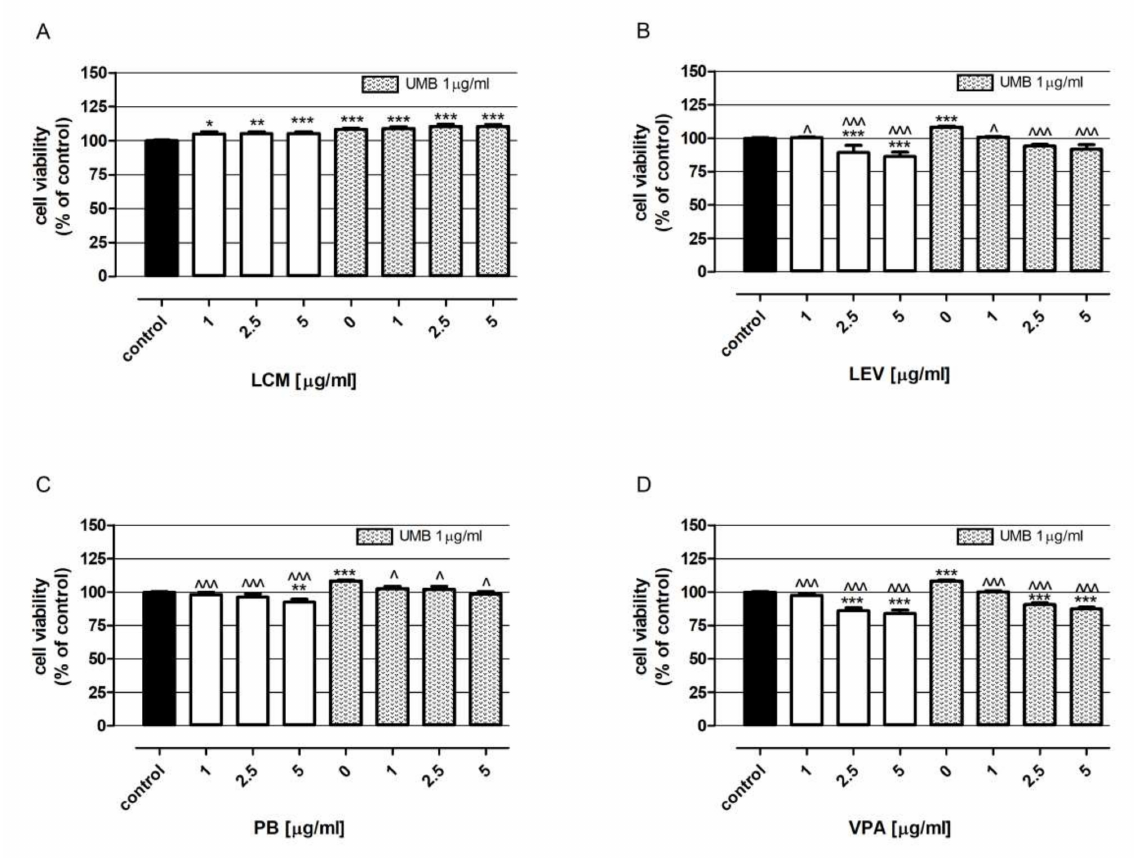
Figure 4. UMB impact on the biological activity of LCM ( A ), LEV ( B ), PB ( C ) and VPA ( D ) in neurons derived from human neuroblastoma cell line SH-SY5Y. Cells were exposed for 48 h to investigated drugs at concentrations 1, 2.5, and 5 µ g/mL prepared with or without 1 µ g/mL UMB. The control consisted of cells exposed to culture medium alone. Cell viability was measured photometrically using an MTT assay. Results are presented as the mean of at least 4 measurements. Statistically significant differences compared to the control at * p < 0.05, ** p < 0.01, *** p < 0.001;statistically significant differences compared to the UMB at ˆ p < 0.05, ˆˆˆ p < 0.001. One-way ANOVA test and Tukey’s post-hoc